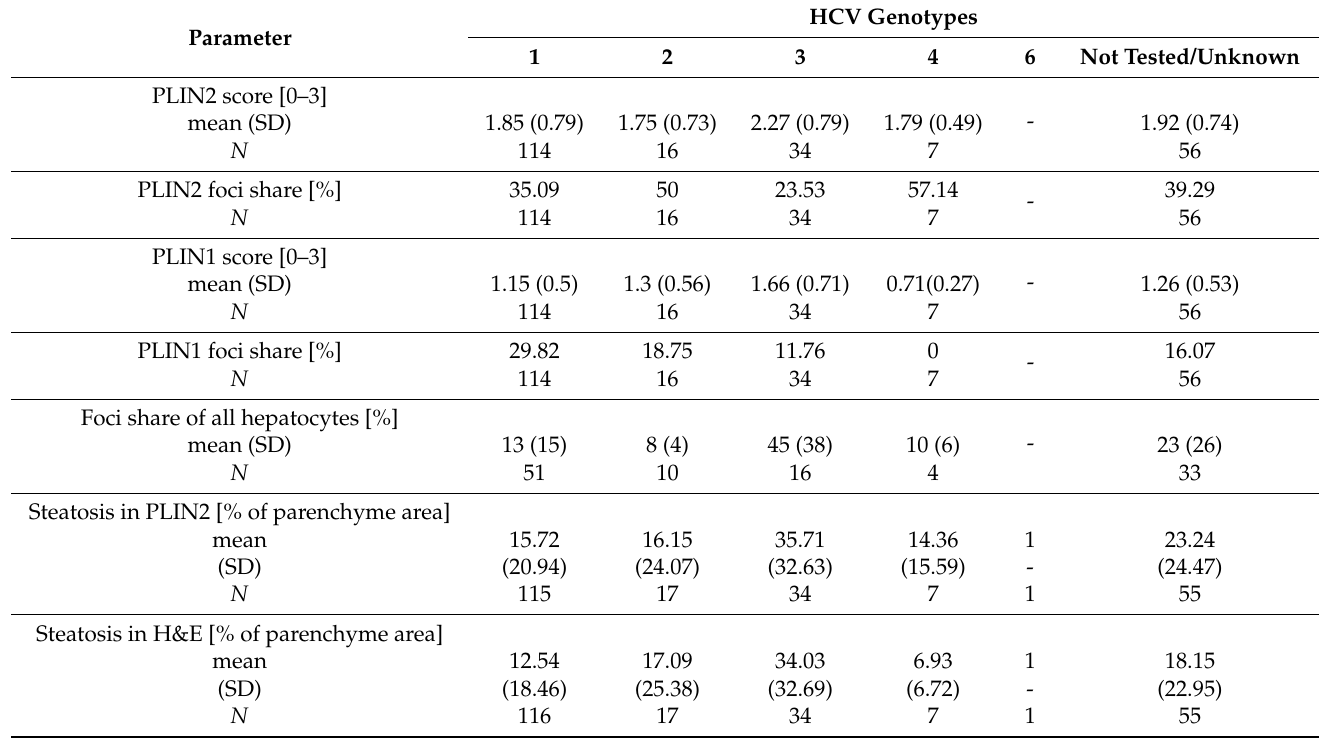
Table 1. Perilipins in different HCV genotypes.